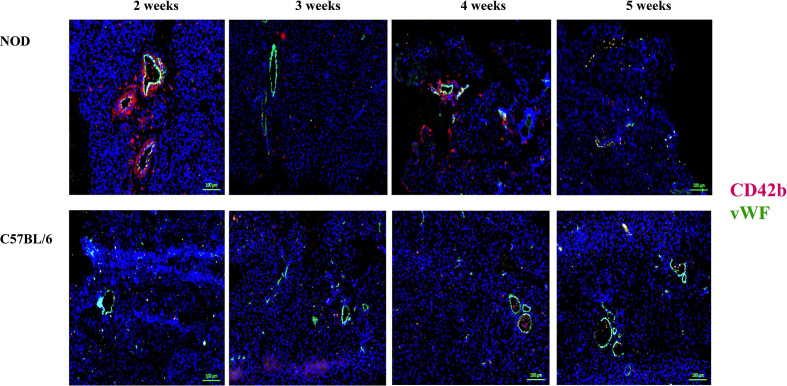
Post-natal pancreas from NOD female mice exhibit non-physiologica CD42b and vWF co-localization inside the pancreas as early as 2 weeks of age. Serial sections from formalin-fixed paraffin-embedded pancreata of 2-5 week old female NOD and C57BL/6 mice were stained with fluorochrome-tagged antibodies to CD42b and von Willebrand factor (vWF). Immunofluorescence shown is representative of outcomes observed in at least three individual mice of each strain. Bar at the bottom of each image represents the length of 100 μm.